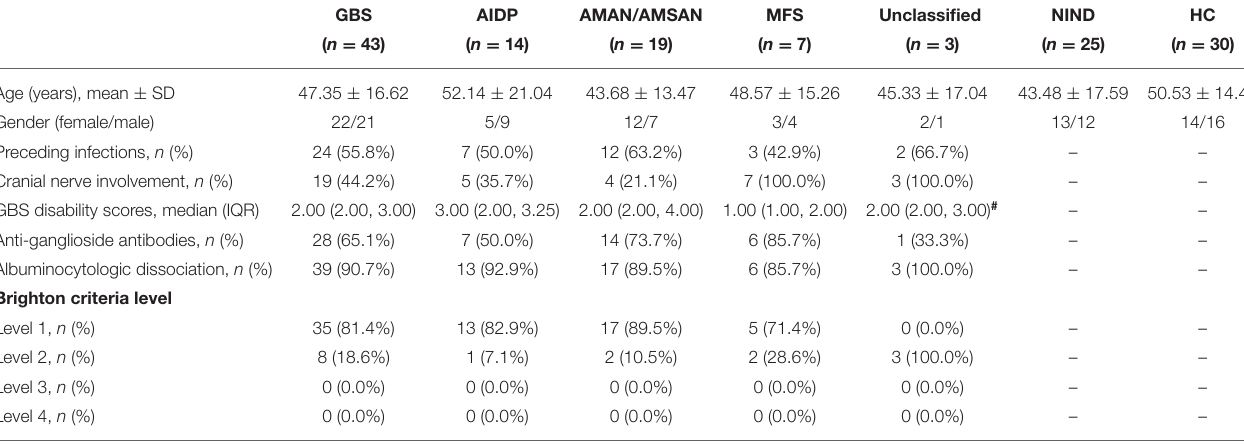
TABLE 1 | Demographic and clinical features in patients with GBS, NIND, and healthy controls. GBS